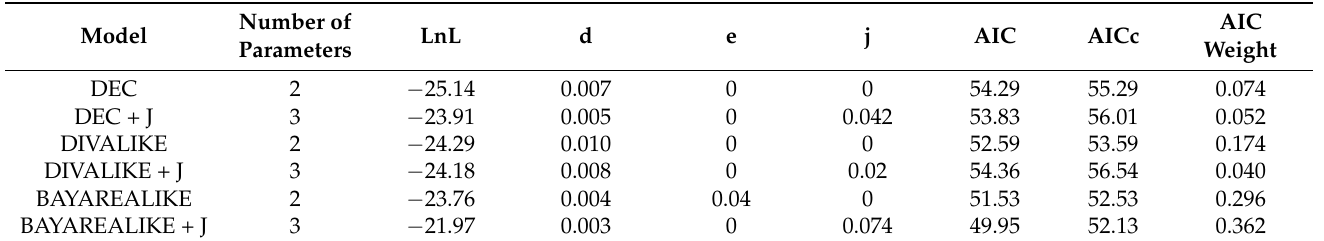
Table A3. Results from BioGeoBEARS models testing.